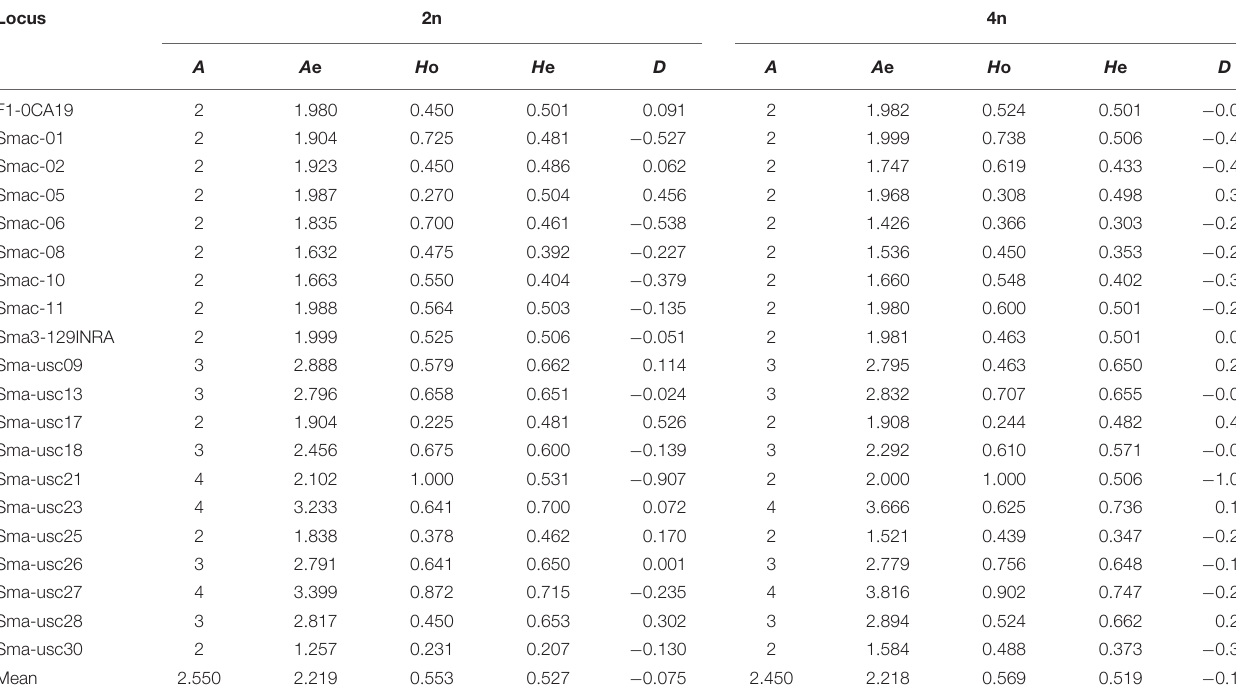
TABLE 4 | The genetic diversity index of diploid (2n) and 4n populations. Locus 2n